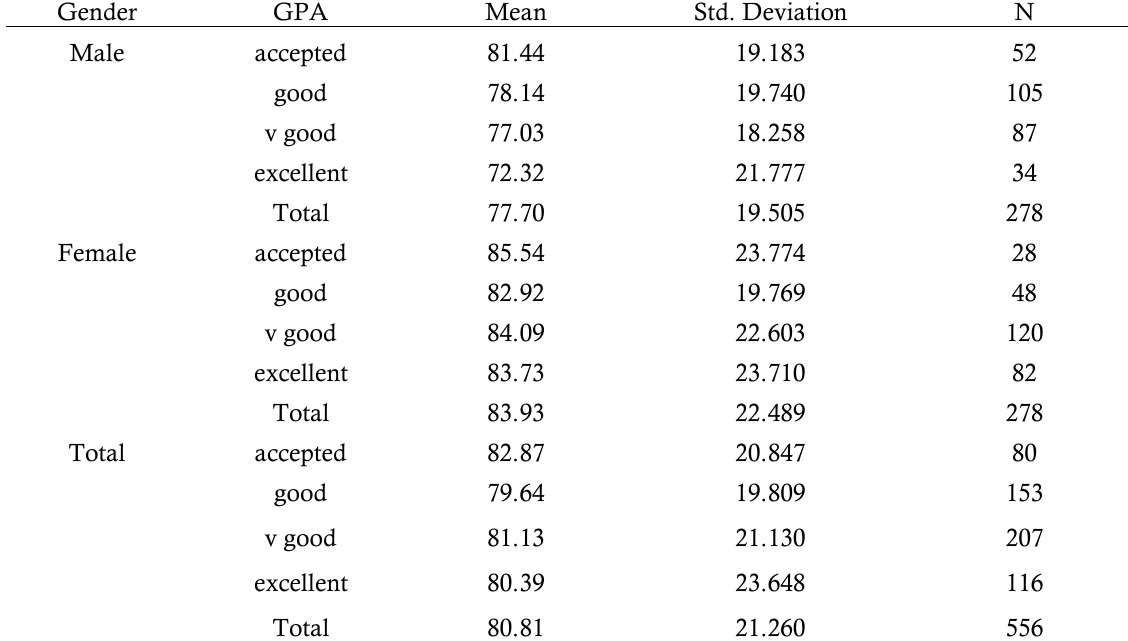
Table 4. Means and standard deviations of alexithymia